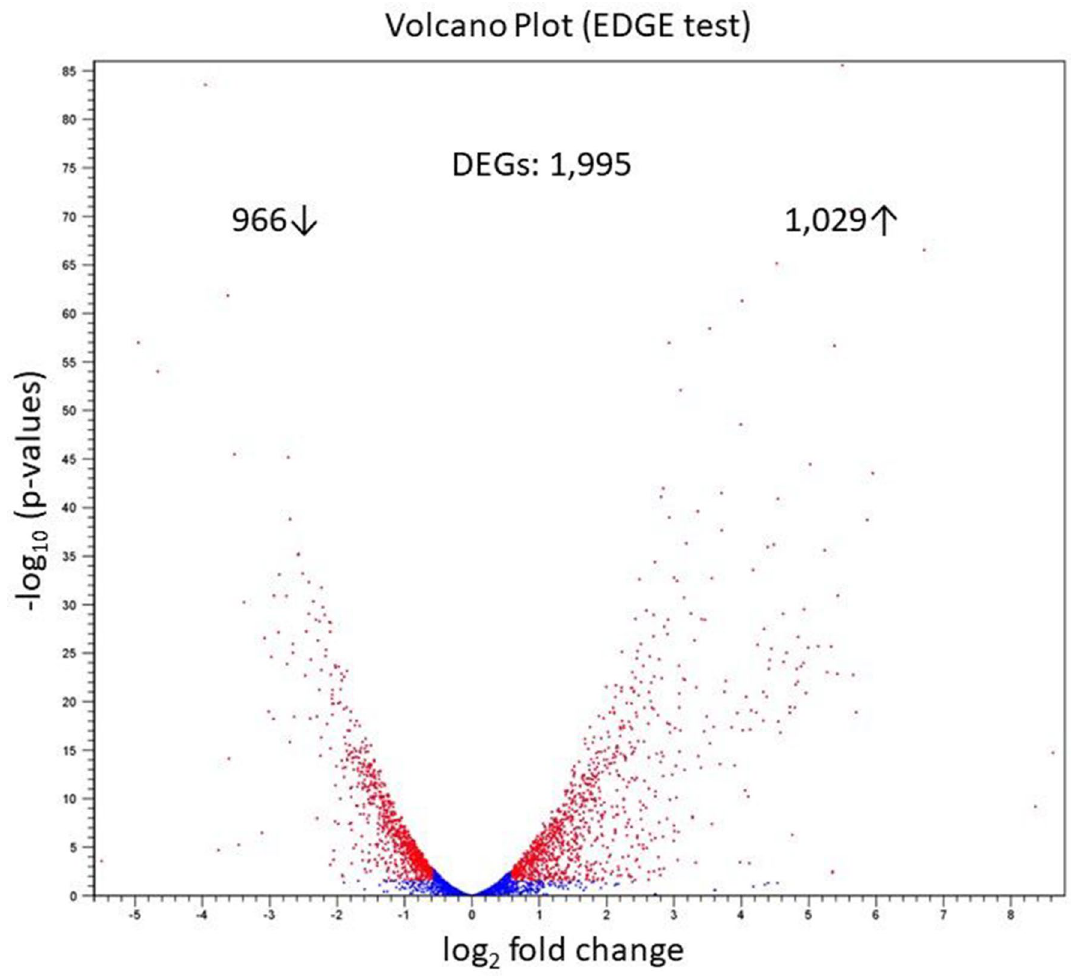
genes (DEGs) with a log 2 fold change ≥ 1.5 or ≤ − 1.5 are depicted as red dots, insignificant as blue dots. The numbers aside the arrow pointing up represent the number of upregulated genes and the numbers aside arrow pointing down represent the number of downregulated genes in planta